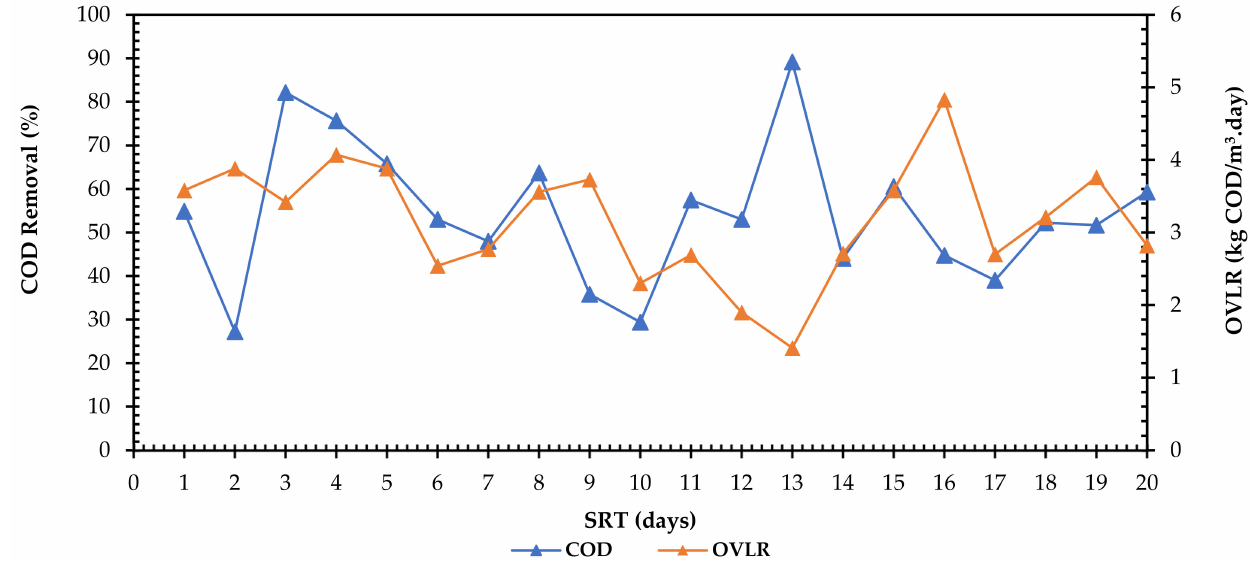
Figure 6. COD removal with variation in